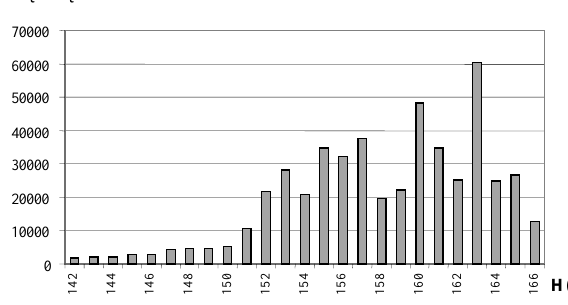
Fig 6. Histogram of digital terrain model created from stereodigitalized height points Stereofotogrametriškai sudarytas SRM paviršius, skirtingai nei gautas interpoliuojant horizontales, kinta tolygiai (6 pav.).